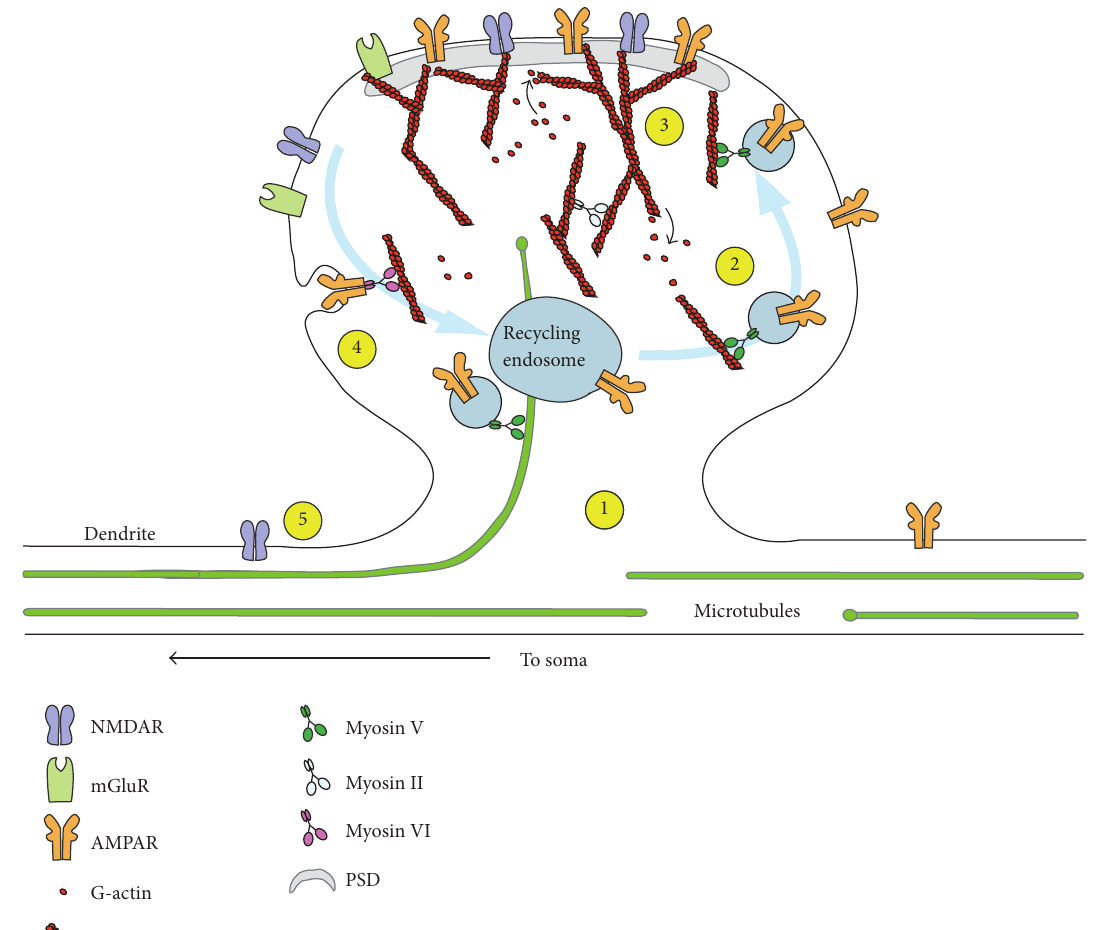
Figure 1: Schematic representation of the cytoskeleton-dependent trafficking of neurotransmitter receptors. Depicted are the key structures of the synapse and associated cytoskeletal molecules. Numbers indicate the following steps: (1) Myosin V traffics vesicles with receptors from the soma to the distal dendritic sites via microtubules (MT) [116]. MT plus ends are indicated by green circles. (2) Once within spines, myosin V transports receptors to plasma membrane via actin filaments [117]. (3) Anchoring of receptors in the PSD relies on myosin II contractile force on actin cytoskeleton in combination with constant actin treadmilling/turnover [48]. Lateral diffusion of receptors to and from the PSD to presynaptic regions can occur. (4) Receptor internalization involves myosin VI activity. Myosin VI transports internalized receptors to endosomal organelles, facilitating recycling of receptors back to the membrane or to degradation pathways [95]. (5) Receptors can also travel between the PSD and peripheral sites [118,